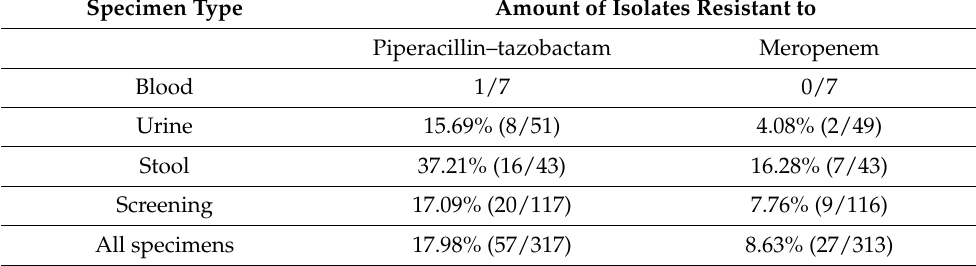
Figure 3. ( a ) Minimum inhibitory concentrations (MICs) for the tested antibiotics (part 1). ( b ) Minimum inhibitory concentrations (MICs) for the tested antibiotics (part 2). ( c ) Minimum inhibitory concentrations (MICs) for the tested antibiotics (part 3). The gray bars indicate a low sample size. Table 1. Relative and absolute amounts of the isolates which were considered resistant to piperacillin–tazobactam and meropenem according to EUCAST Cl. Br. Tables v. 11.0, grouped by the specimen type.